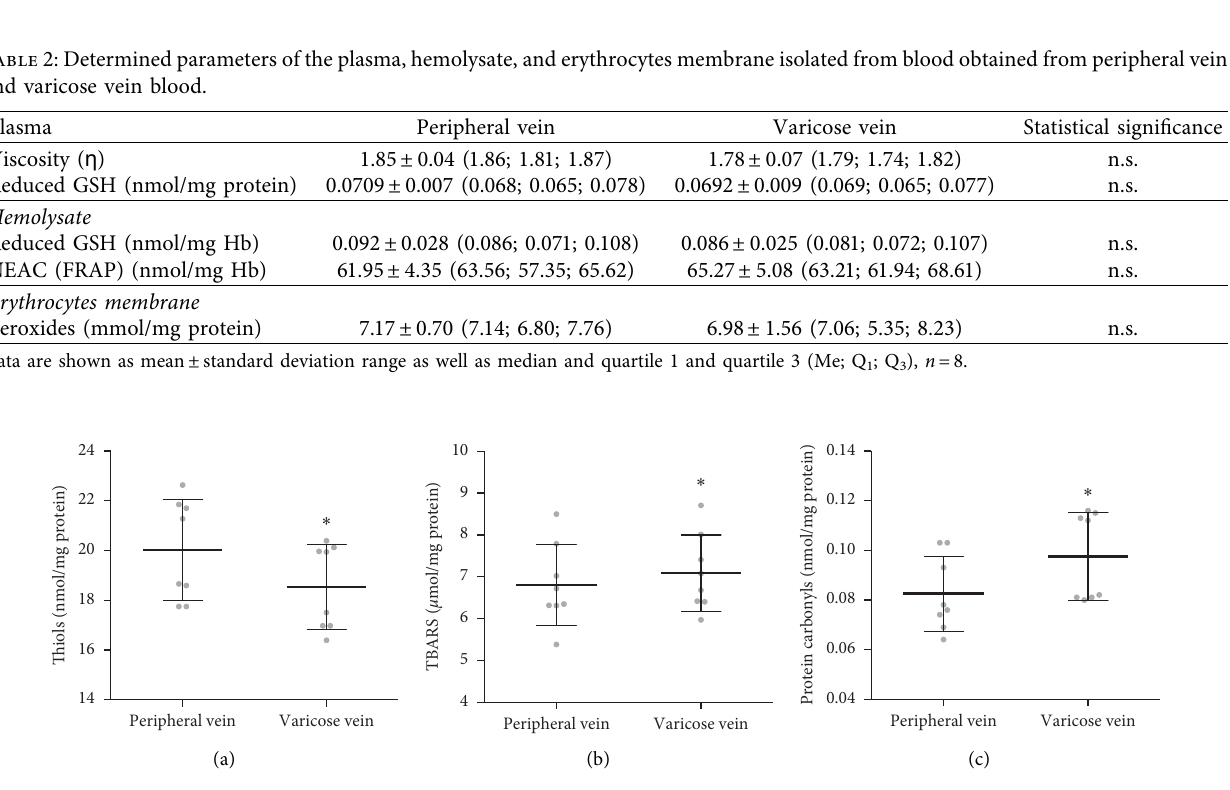
Figure 1: The levels of free thiols (a), TBARS (b), and protein carbonyl compounds (c) in the plasma obtained from peripheral and varicose veins. Data are shown as mean ± range of standard deviation, n � 8. ∗ p < 0 . 05 is the significant